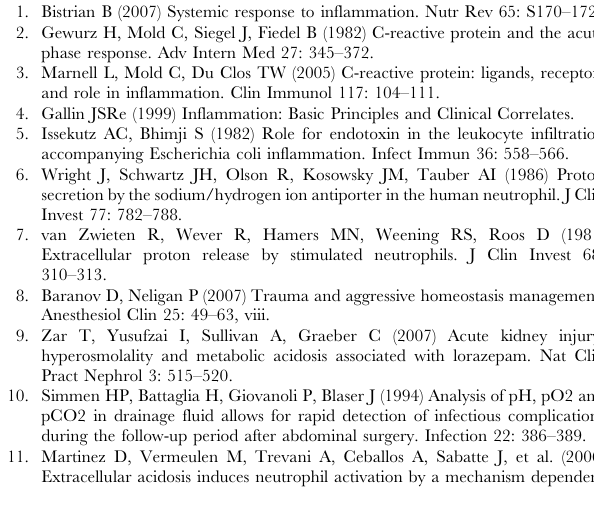
(HFL) was immobilized first. In both positions, H-ficolin was not able to bind to CRP. (B) Yeast-two hybrid assay to check whether CRP interacts with M-ficolin. Colonies growing on the SD-Trp- Leu plate indicate the successful transformation. Growth on the QDO plates indicates interaction between CRP and M-ficolin. Transformation of the empty vector plasmid with the protein of interest excludes the possibility of autoactivation. pY1GAL4 plasmid was used as a positive control. Figure S6 Phagocytosis of the opsonized beads. In normal condition, even when all the amplification pathway components were added, they were not functional due to lack of interaction between CRP and L-ficolin. In infection-inflammation condition, addition of all the amplification pathway components showed the fluorescence signal due to CRP:L-ficolin interaction, whereas all the controls do not display any fluorescence signal. The image was taken with an Olympus Fluorescence Microscope (BX 60; magnification: 400 6 ). Figure S7 Purity of human C-reactive protein. (A) One m g of CRP was resolved on 12% reducing SDS PAGE and stained with Commassie-blue, showing , 98% purity. (B) Mass spectrometry of the CRP. One m g of CRP was trypsin-digested and analyzed by MALDI-TOF-TOF to check for purity. Within the significant range ( P , 0.05), CRP was substantially pure. Grey boxes show the fragments that are consistent with CRP fingerprints in the database. Protocol S1 Supporting Materials and Methods Found at: doi:10.1371/journal.ppat.1000282.s008 (0.05 MB DOC) Video S1 The real-time imaging of bacterial clearance elicited by serum components in normal and infection-inflammation conditions–Video S1: PAO1-pDSK incubated with 10% patient serum in infection-inflammation condition.